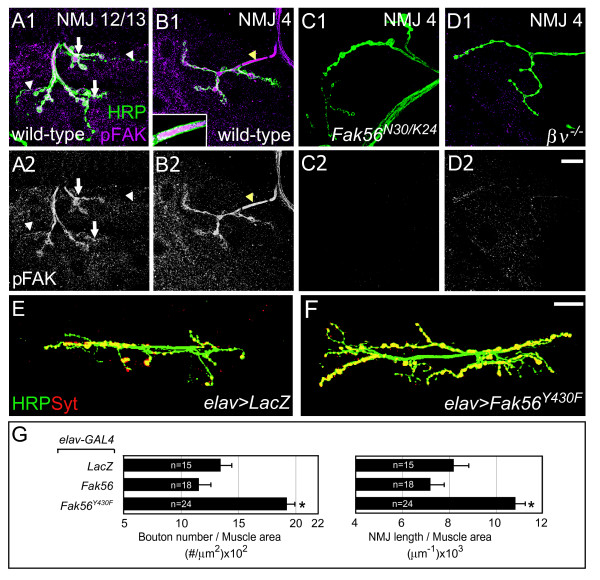
Distribution and requirement of phospho-FAK (pFAK) at presynapses of neuromuscular junctions (NMJs). (A-D) Active Fak56 (pFAK in magenta) recognized by anti-FAK [pY397] antibodies localized at presynapses of NMJ 12/13 (A) and NMJ 4 (B) in wild-type larvae, and was absent in Fak56N30/K24 (C), and reduced in βν1/1 (D), with co-stained horseradish peroxidase (HRP) in green. White arrows and arrowheads indicate Ib and Is boutons, respectively. Images in (A-D) come from a single section of the Z-stack confocal scanning. Note punctate distribution in muscles and strong expression in axonal trunks (yellow arrowhead in B1) surrounded by HRP membrane staining. The inset image in B1 is the inclusion of pFAK inside the incoming axon from a Z-stack section crossing the middle of the axon. (A2-D2) are diphospho-ERK (dpERK) images in white. (E-F) Images of NMJ 6/7 are shown as for Figure 1. Neuronal overexpression of LacZ control (E) or Fak56Y430F (F) by elav-GAL4 displays a NMJ overgrowth phenotype. (G) Quantification of NMJ 6/7 phenotypes for elav>LacZ, elav>Fak56 and elav>Fak56Y430F. Note that elav>Fak56 shows slight reduction in bouton number and NMJ length when compared to elav>LacZ control (E) but these reductions were not statistically significant (p = 0.413 for bouton number and p = 0.125 for branch length in Student's t-test). Asterisks indicate significant difference by Student's t test (p < 0.05) and error bars represent the standard error of the mean (SEM).